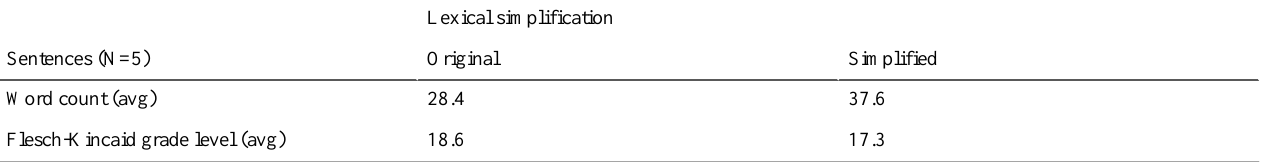
Table 1. Text snippet characteristics.